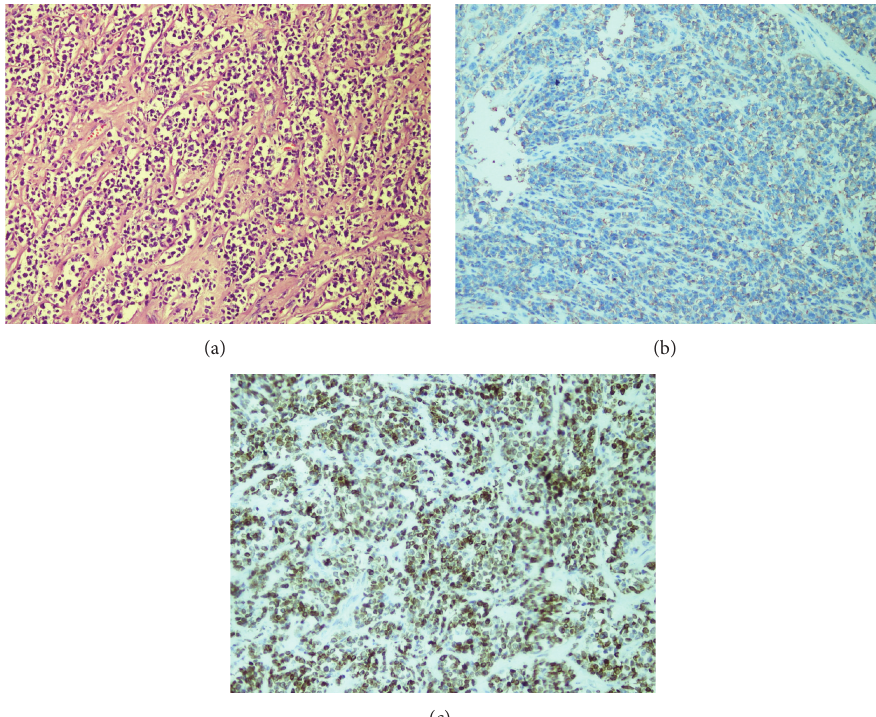
Figure 2: Diffuse infiltration of malignant lymphoid cells (H&E × 100) (a) stained with CD20 (b) and bcl-2 (c) (immunohistochemistry × 40 and × 100, resp.).